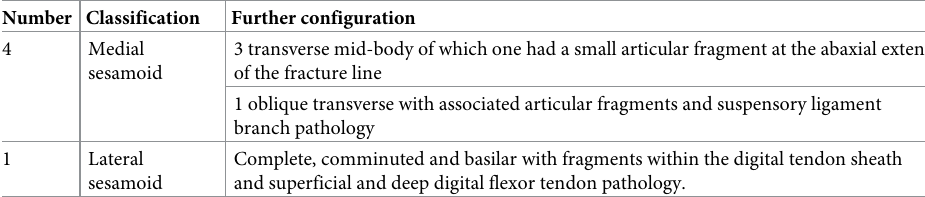
Table 5. Proximal sesamoid